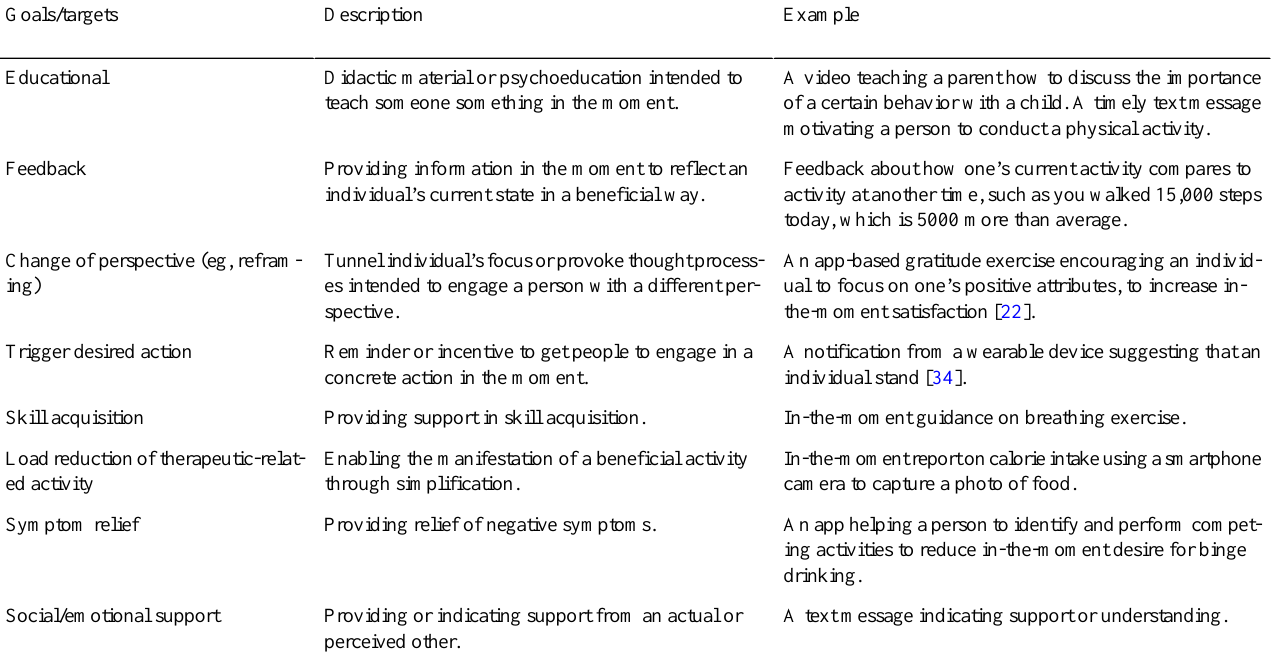
Table 2. Common goals of digital micro intervention events, descriptions, and related